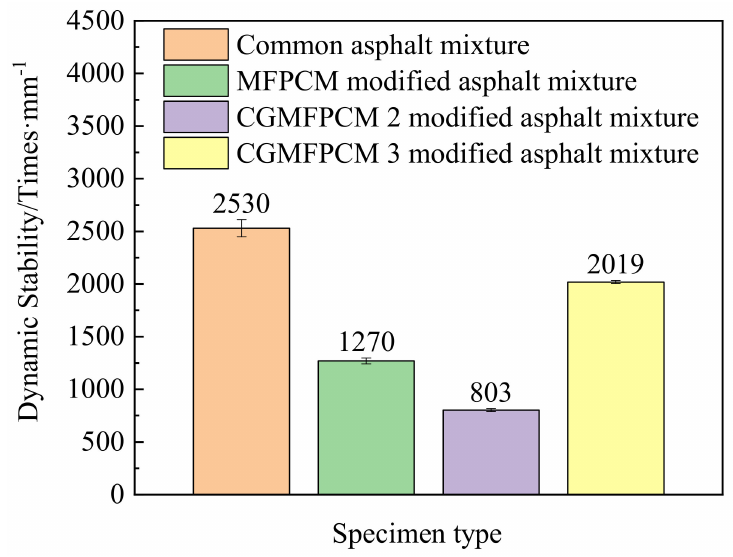
Figure 7. Wheel tracking test results of common and modified asphalt